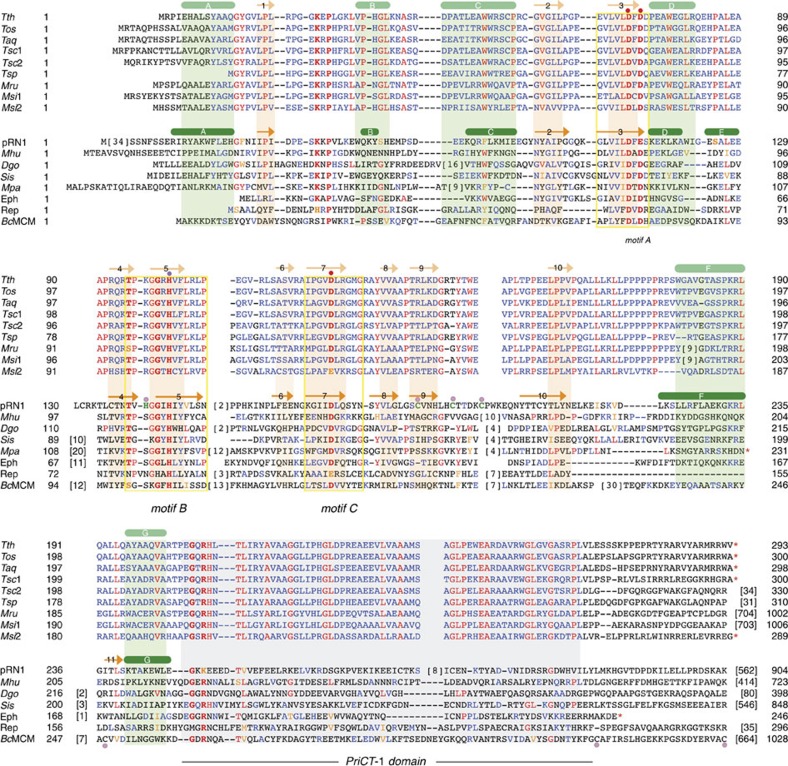
Multiple amino acid sequence alignment of the closest TthPrimPol orthologues.The first block of sequences corresponds to Thermales (Thermus and Meiothermus) and the second block includes Si/pRN1 PrimPol and some other putative bifunctional primases/polymerases from bacteria, archaea and phage; in addition, plasmidic Rep (a potential PrimPol) and BcMCM PrimPol were included. Numbers in parentheses indicate the number of amino acid residues not shown. Invariant or conserved residues among Thermales (first set of sequences) were labelled in red and blue letters, respectively. Identity matches in the second set of sequences were equally coloured. The alignment defines several conserved regions, including the highly conserved motifs A, B and C (boxed in yellow), characteristic of AEP-like primases. Experimentally determined secondary structure elements in Si/pRN1 PrimPol are indicated above pRN1 sequence (α-helices, lettered cylinders; green) and β-strands (numbered arrows; orange). Modelled secondary structure elements in TthPrimPol are tentatively depicted above the TthPrimPol sequence (see also Fig 1b). The corresponding aligned regions are boxed in the same colours to emphasize structural conservation between TthPrimPol and the AEP core of pRN1. The C-terminal region of TthPrimPol, conserved in other Thermales (boxed in grey), aligns with the PriCT-1 domain of Rep and Eph primases; this region is not yet crystallized in pRN1 and it has been described as pRN1_helical29. Dots indicate invariant residues acting either as metal (red), nucleotide (purple) or Zn (magenta) ligands. Selection of the closest TthPrimPol homologues and multiple alignment of their amino acid sequence were initially performed with the BLAST programme and further adjusted manually to maximize similarities with the structured regions of pRN1 PrimPol. Nomenclature: YP_004631.1 T. thermophilus (Tth); YP_006971229.1 Thermus oshimai (Tos); WP_003046664.1 Thermus aquaticus (Taq); YP_004202830.1 Thermus scotoductus (Tsc1); YP_004202855.1 T. scotoductus (Tsc2); ETN89075.1 Thermus sp (Tsp); YP_003508539.1 Meiothermus ruber (Mru); YP_003684976.1 Meiothermus silvanus (Msi1); YP_003684747.1 M. silvanus (Msi2); AAC44111.1 plasmid pRN1 ORF904 from S. islandicus (pRN1); YP_502469.1 Methanospirillum hungatei (Mhu); YP_006262572.1 Deinococcus gobiensis (Dgo); YP_002829910.1 S. islandicus (Sis); YP_003357218.1 Methanocella paludícola (Mpa); AFO10831.1 Enterococcus phage EfaCPT1 (Eph); YP_009074444.1 Shigella sonnei Rep protein from plasmid ColE4-CT9 (Rep); WP_044797243 PrimPol-helicase from B. cereus (BcMCM).